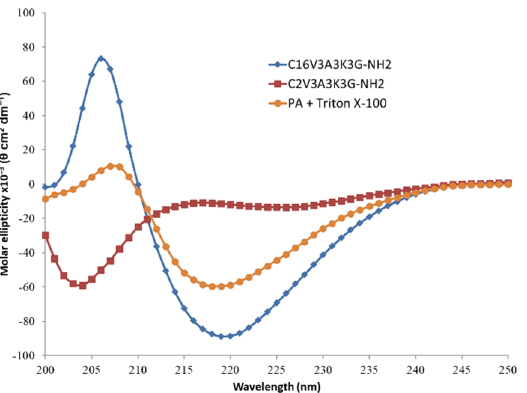
Figure 3. Circular dichroism (CD) spectra of C 16 V 3 A 3 K 3 G-NH 2 (blue; [C] = 4 g · L − 1 ), C 2 V 3 A 3 K 3 G-NH 2 (red; [C] = 4 g · L − 1 ) and C 16 V 3 A 3 K 3 G-NH 2 ([C] = 4 g · L − 1 ) + Triton X-100 ([C] = 1 g · L − 1 ) (orange) in H 2 O at 25 °C.